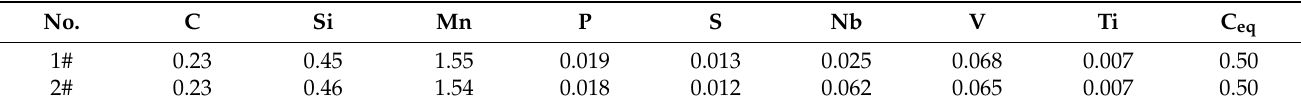
Table 1. Chemical composition of the steels (mass fraction, wt.%).